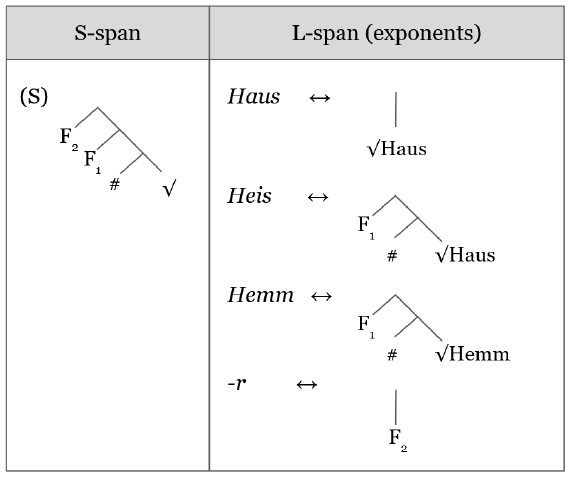
Figure 6. Spellout of PD {r}